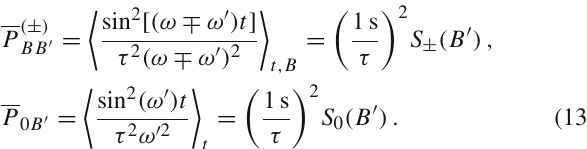
value of B c . In addition, we computed also the mean oscil- lation probability P 0 B (cid:2) for the case when no magnetic field was applied, B =